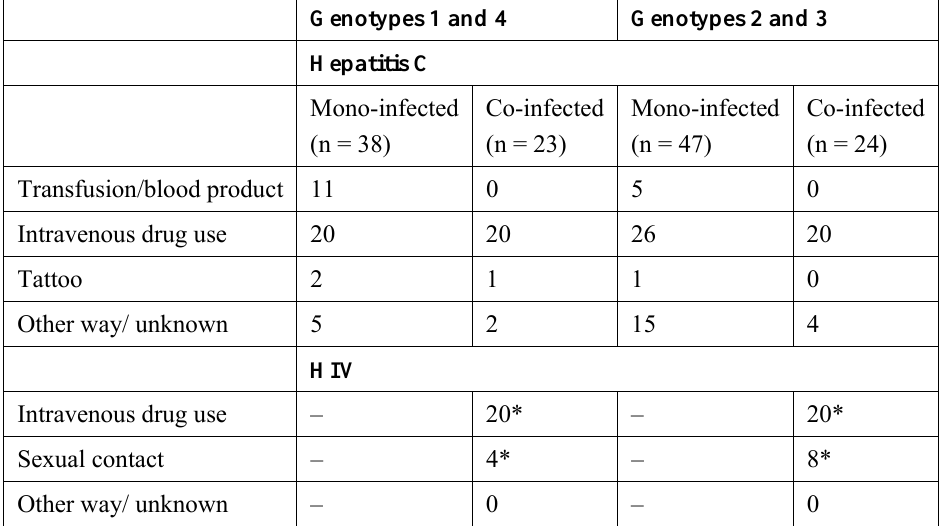
Table 2 Modes of